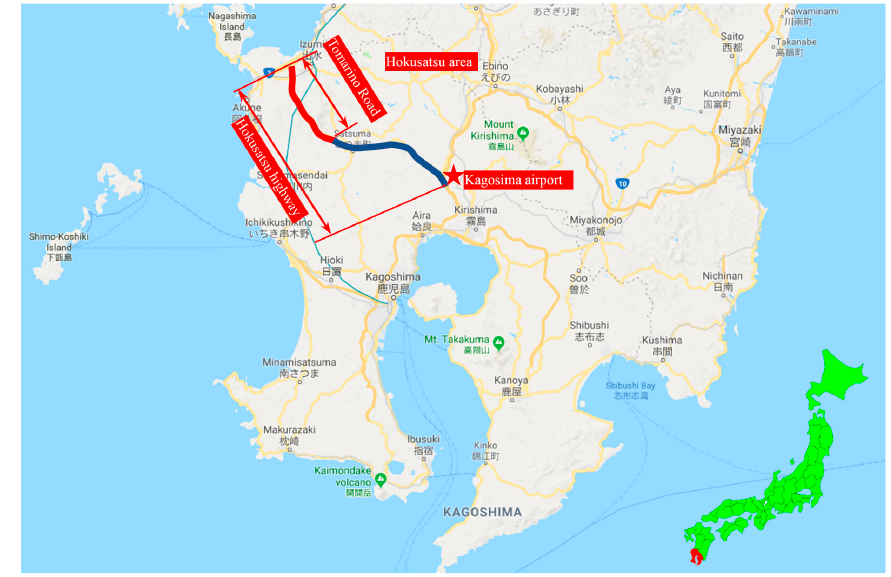
Figure 1. The location of Hokusatsu highway.